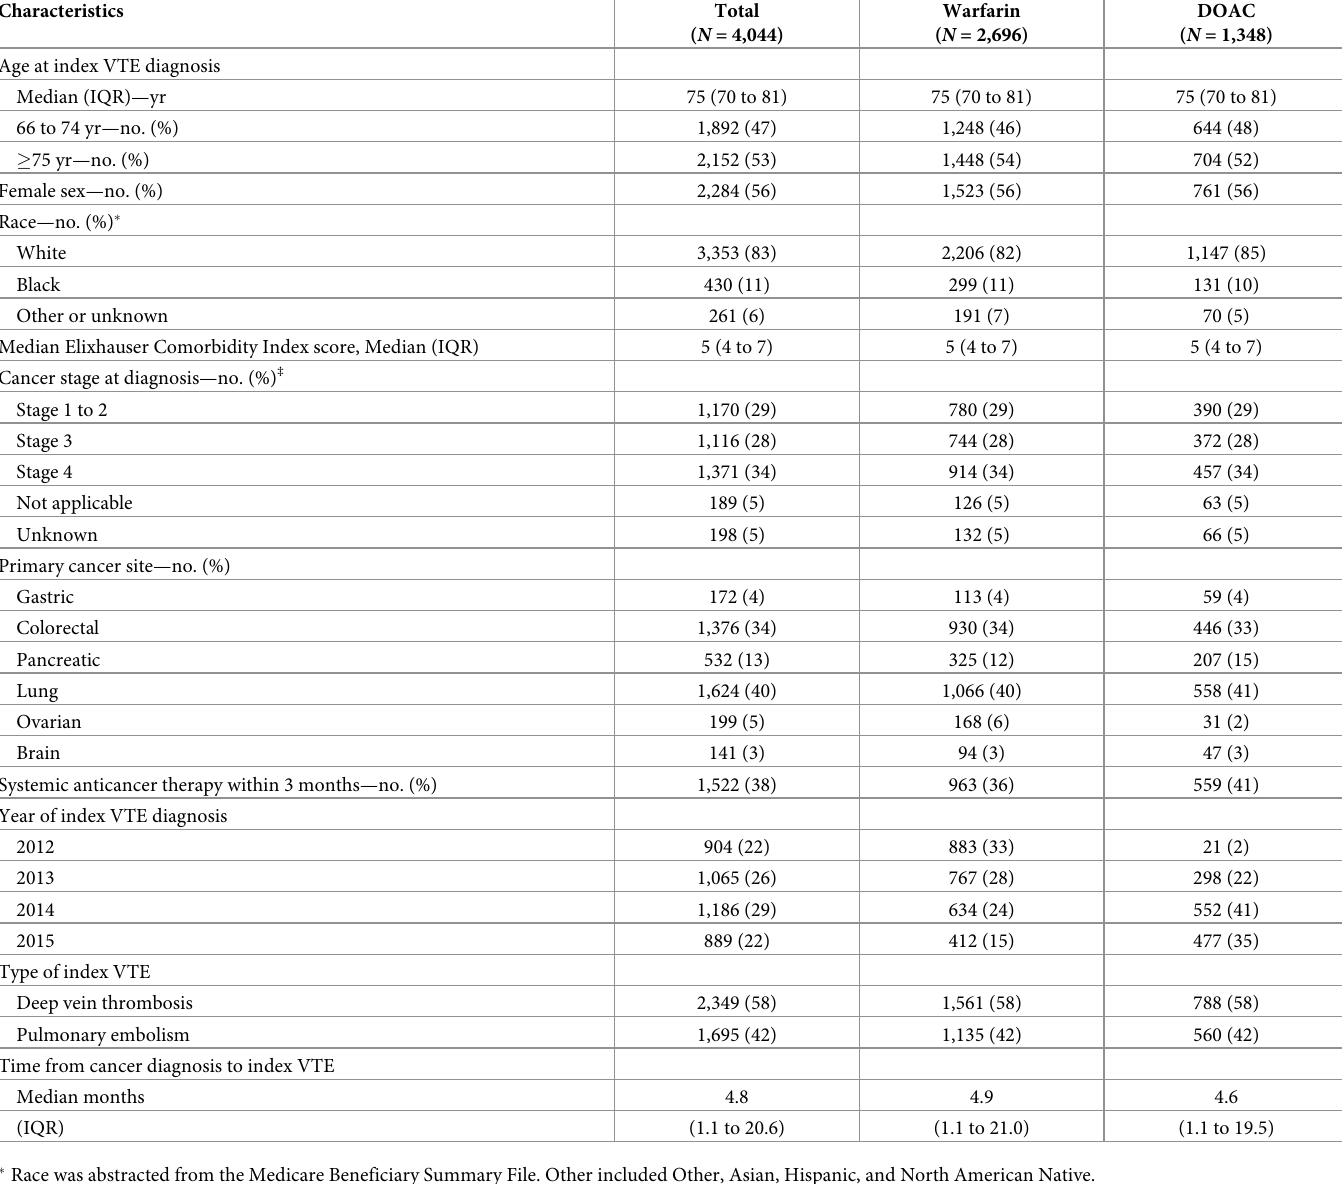
Table 1. Demographic and clinical characteristics of study cohort at baseline after propensity score matching.